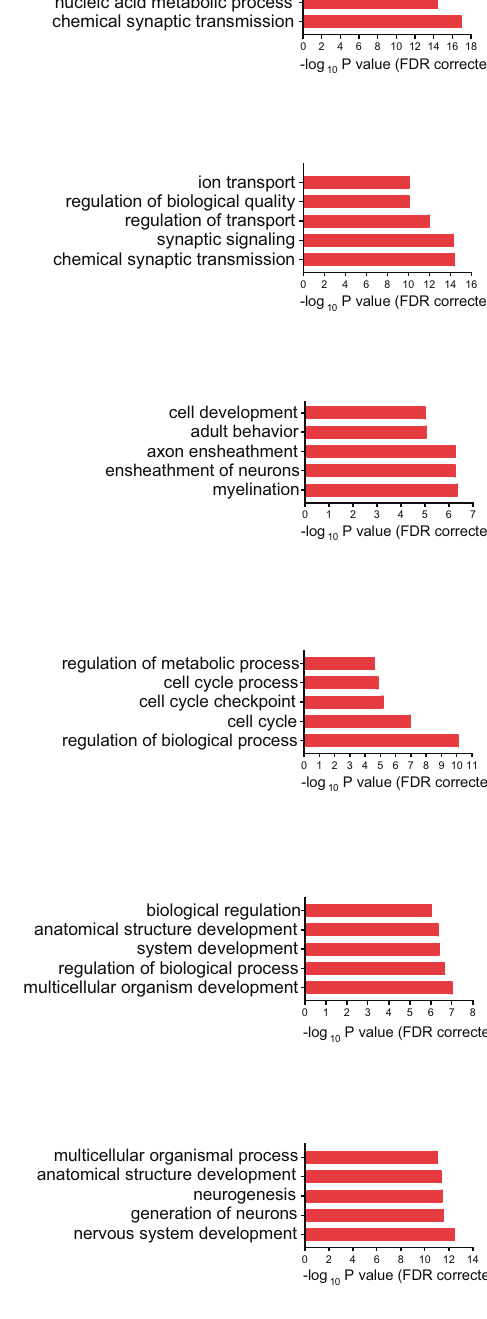
qualityion transport transportregulation of biological signalingregulation of transmissionsynaptic chemical synaptic -log 10 P value (FDR